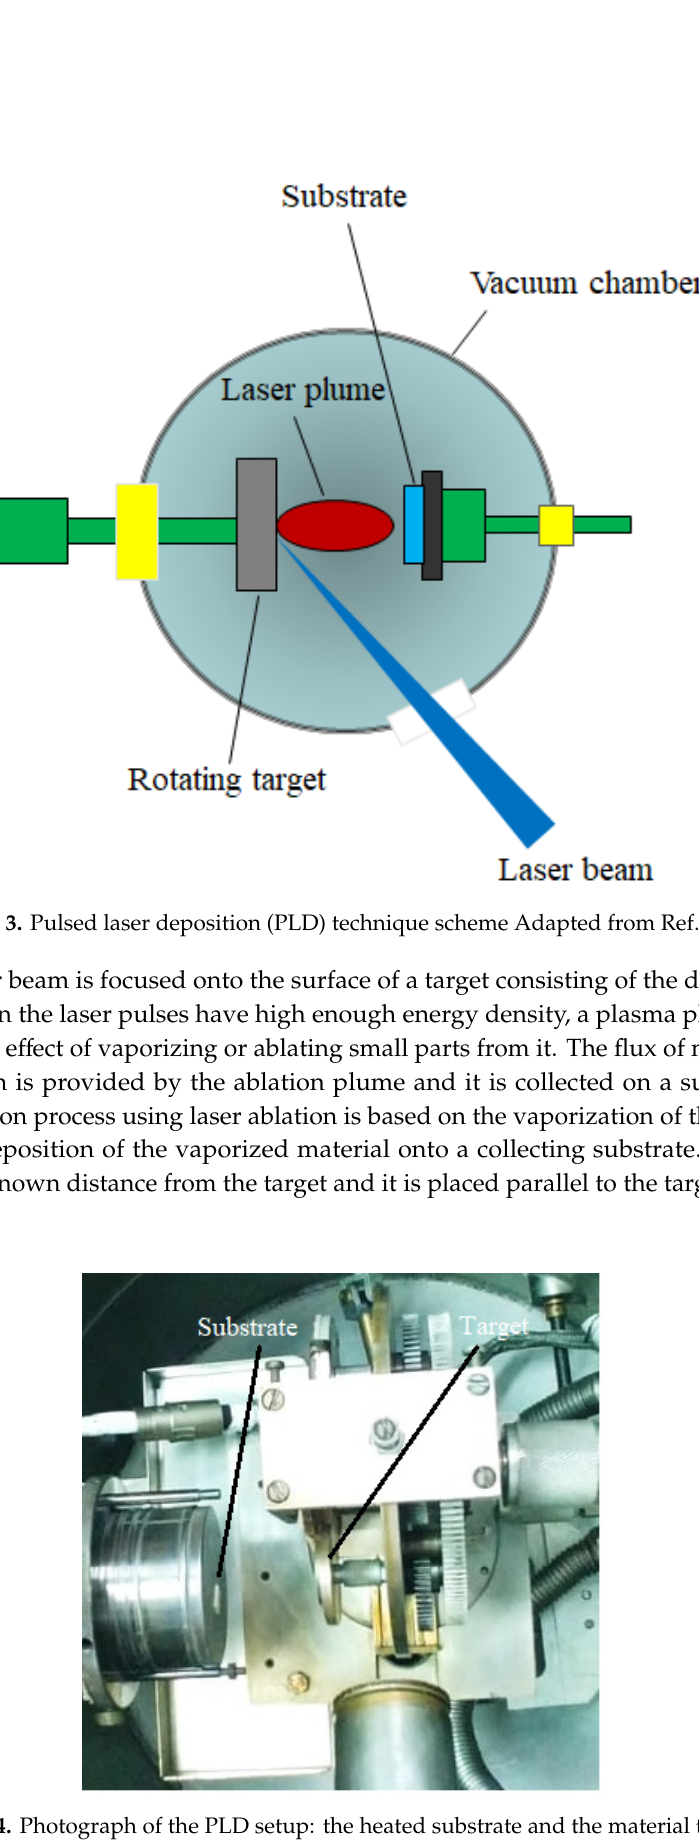
Figure 4. Photograph of the PLD setup: the heated substrate and the material target. The fundamental processes taking place during the laser ablation are as follows: the heating of the irradiated material; the melting, evaporation or sublimation of the heated material; the formation